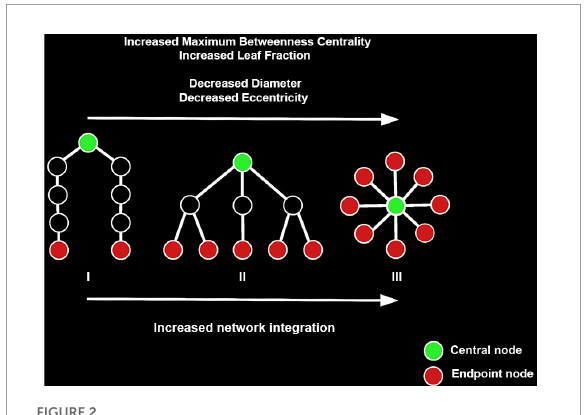
FIGURE2 Examples of three minimum spanning trees (MSTs) consisting of nine nodes. MST structures can be found on a continuum between a path-like tree to a star-like tree, with the figure showing a path-like (I), hierarchical (II), and star-like tree (III). Path-like trees have the drawback that information does not flow easily from node to node. Star-like trees have the advantage that information can flow easily across the network and the downside that the central node might suffer from information overload. As such, a hierarchical tree is the hypothesized optimal topology. Figure adapted from van Lutterveld et al. (2017). The reader is referred to the web version of this paper for the color representation of this